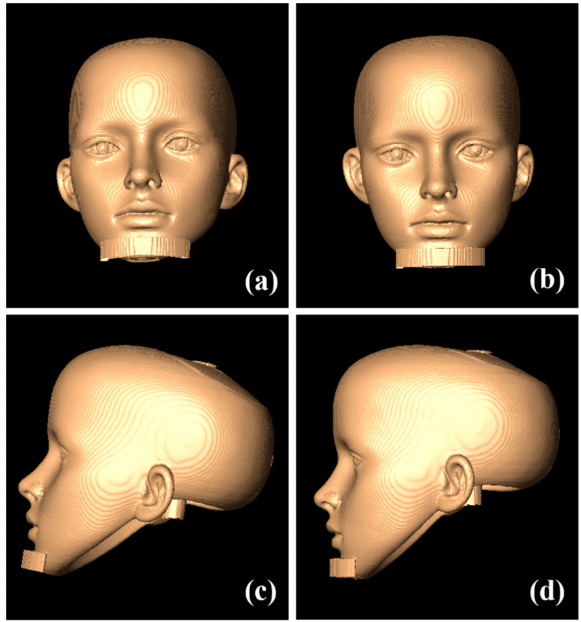
Figure 6. The phantom CT model shown before ( a , c ) and after ( b , d ) NHP rotation.